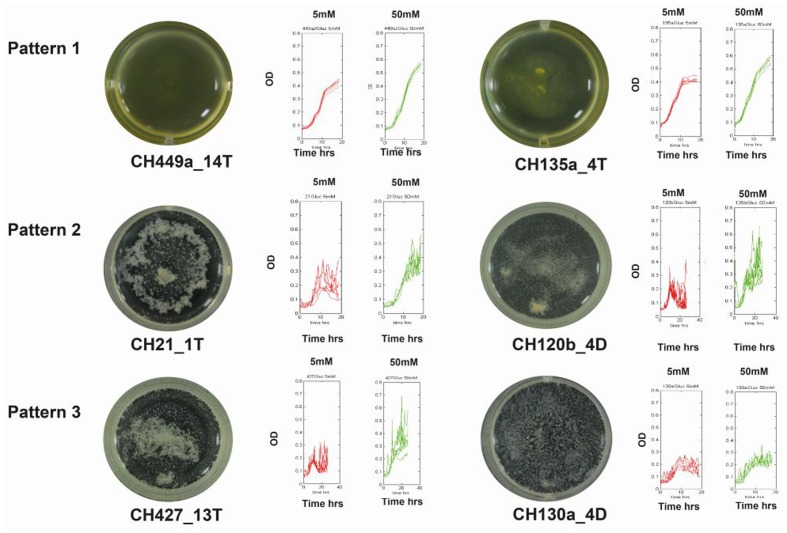
Relationship between growth patterns and biofilm production. Graphic representation of the three typical growth curve patterns at two glucose concentrations. The red and green curves describe growth with 5 and 50 mM glucose, respectively. Photographs at the ends of the figure depict strains at the end of the growth curve for each pattern.